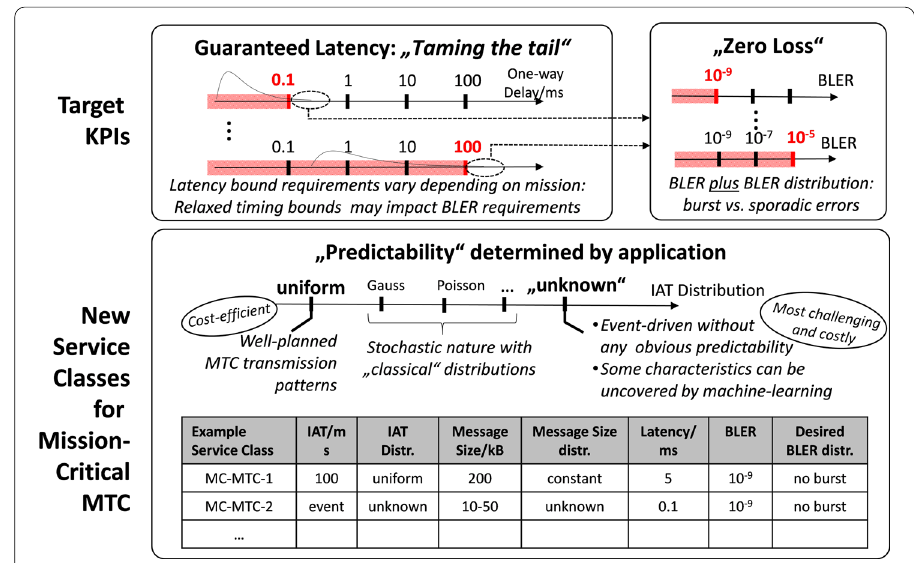
Fig. 5 Mission‑critical MTC challenges. Mission‑critical MTC challenge: taming the tail of latency and error